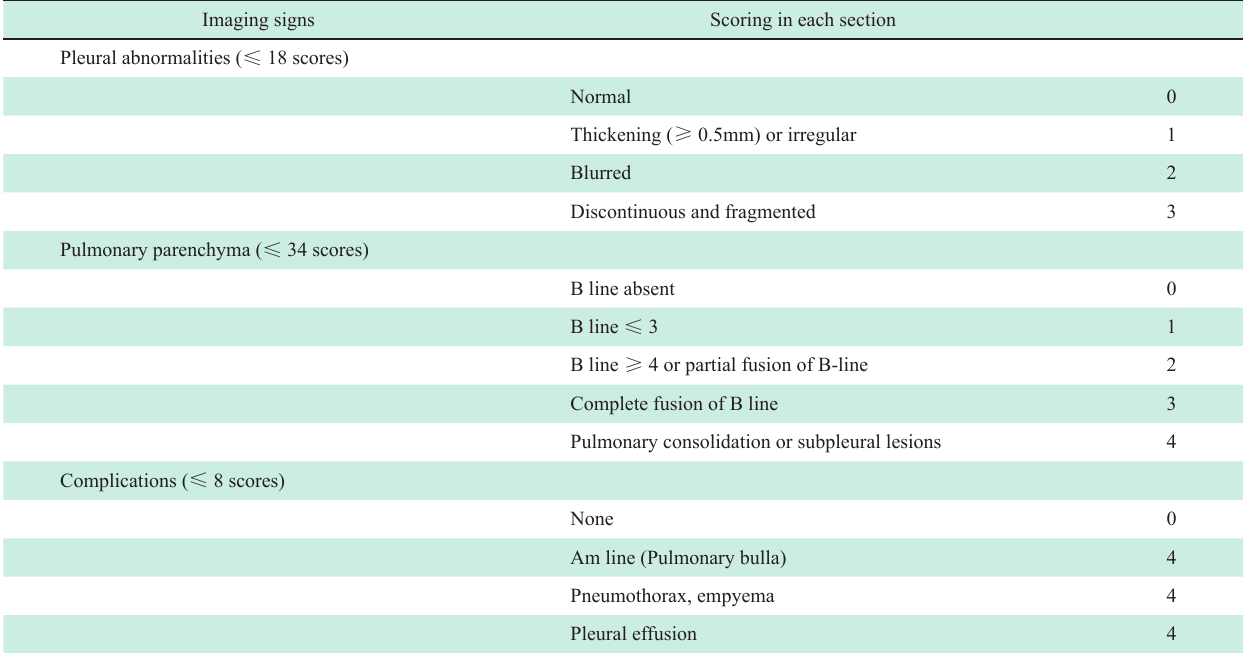
Table 1 Modified transthoracic pulmonary ultrasound evaluation protocol Imaging